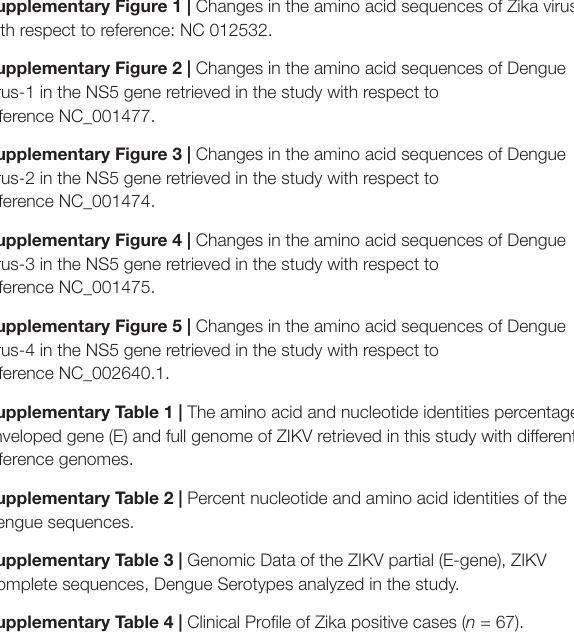
Supplementary Table 4 | Clinical Profile of Zika positive cases ( n =